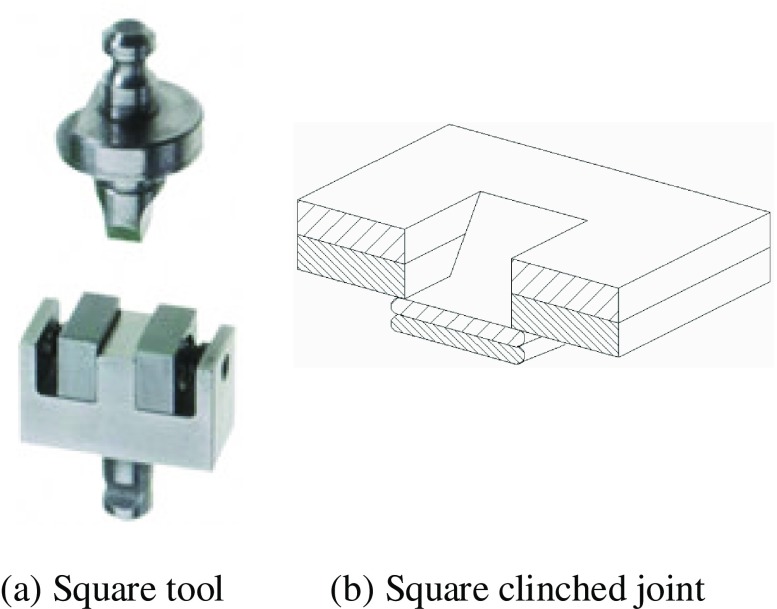
Square clinching.